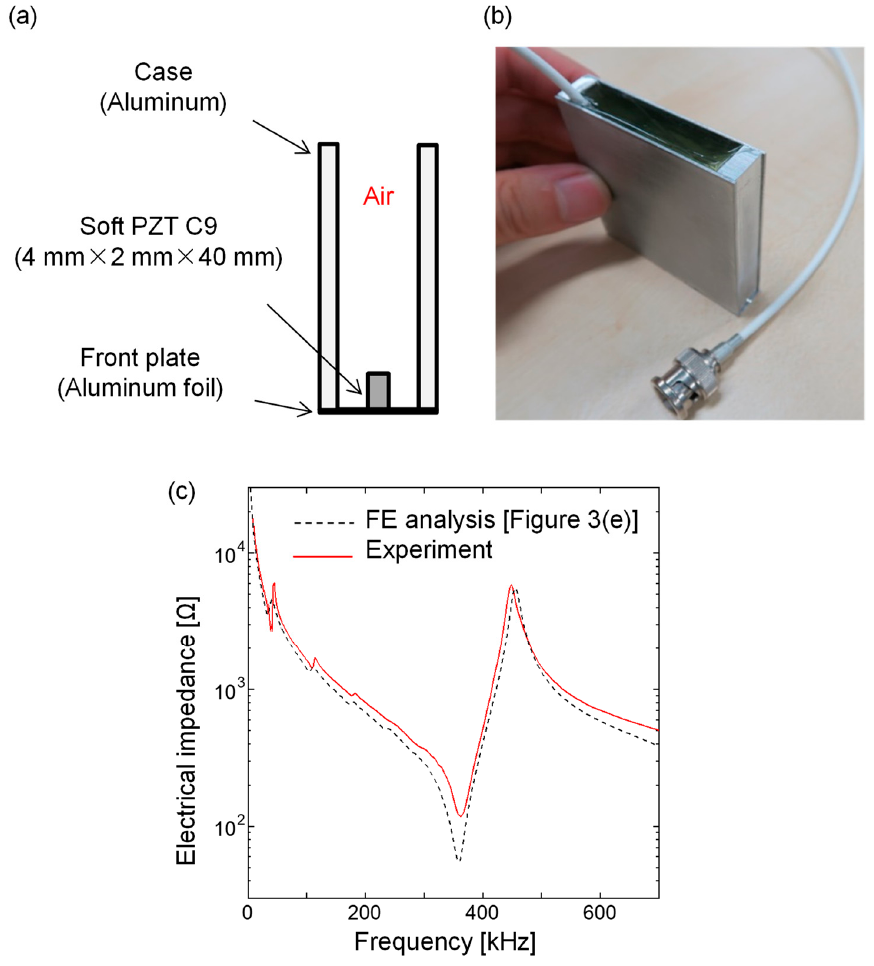
Figure 4. Transducer composed of a single piezoelectric (C9) element with 4 mm thickness and 2 mm width and the spectra of the electrical impedance. ( a ) Schematic illustration; ( b ) photograph of the fabricated transducer; ( c ) electrical impedance spectra.